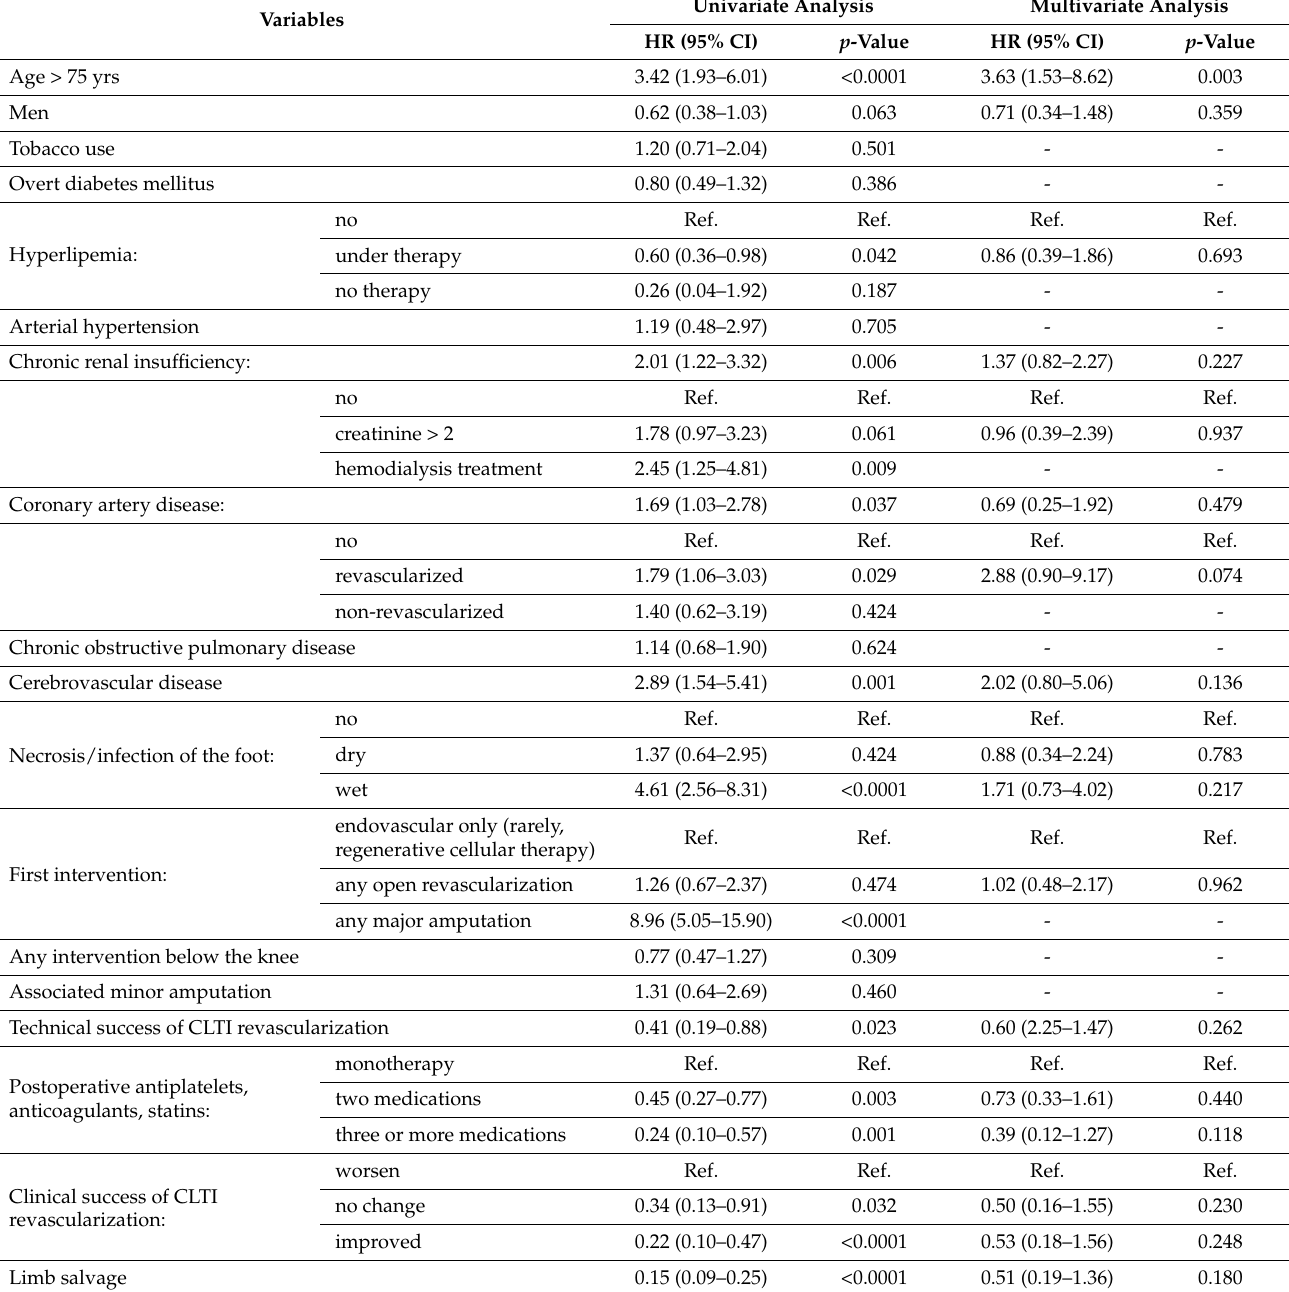
Table 2. Cox regression analysis to assess risk factors for 30 day